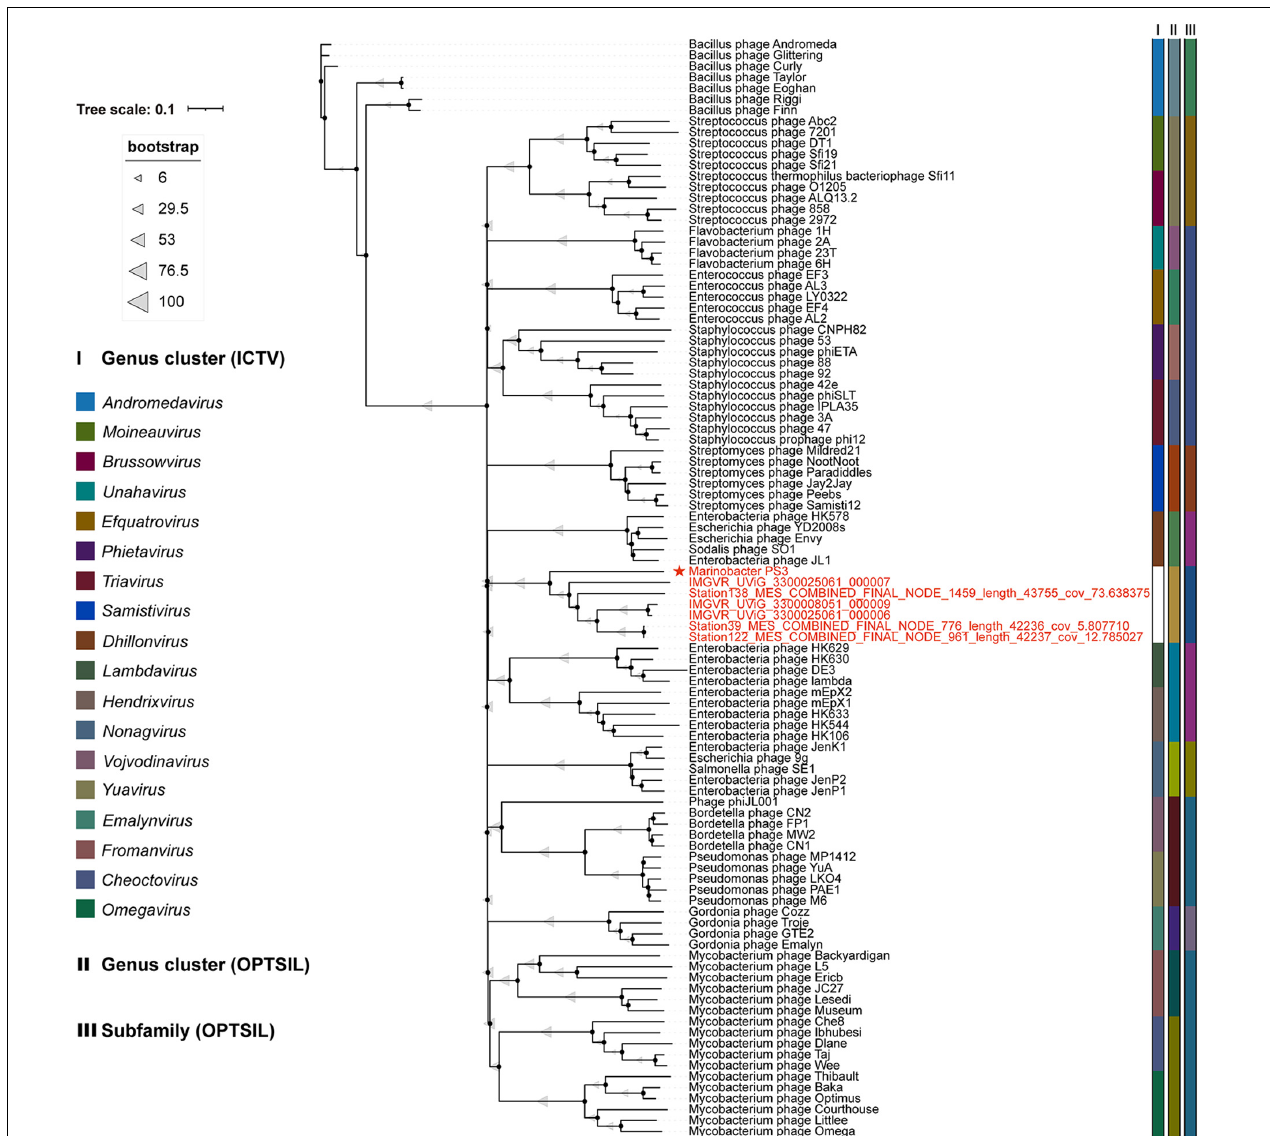
FIGURE 5 | Genome BLAST distance phylogeny (GBDP) tree of 100 siphovirus genomes. vB_MalS-PS3 shows the phylogenomic GBDP trees inferred using the formula D6 and yielding average support of 57%. The numbers above branches are GBDP pseudo-bootstrap support values from 100 replications. The branch lengths of the resulting Virus Classification and Tree Building Online Resource (VICTOR) trees are scaled in terms of the respective distance formula used. The ICTV taxonomy and predicted OPTSIL taxon are shown. Each genus is indicated by a unique color. The members in VC 364_0 ( Figure 4A ) are shown in red.